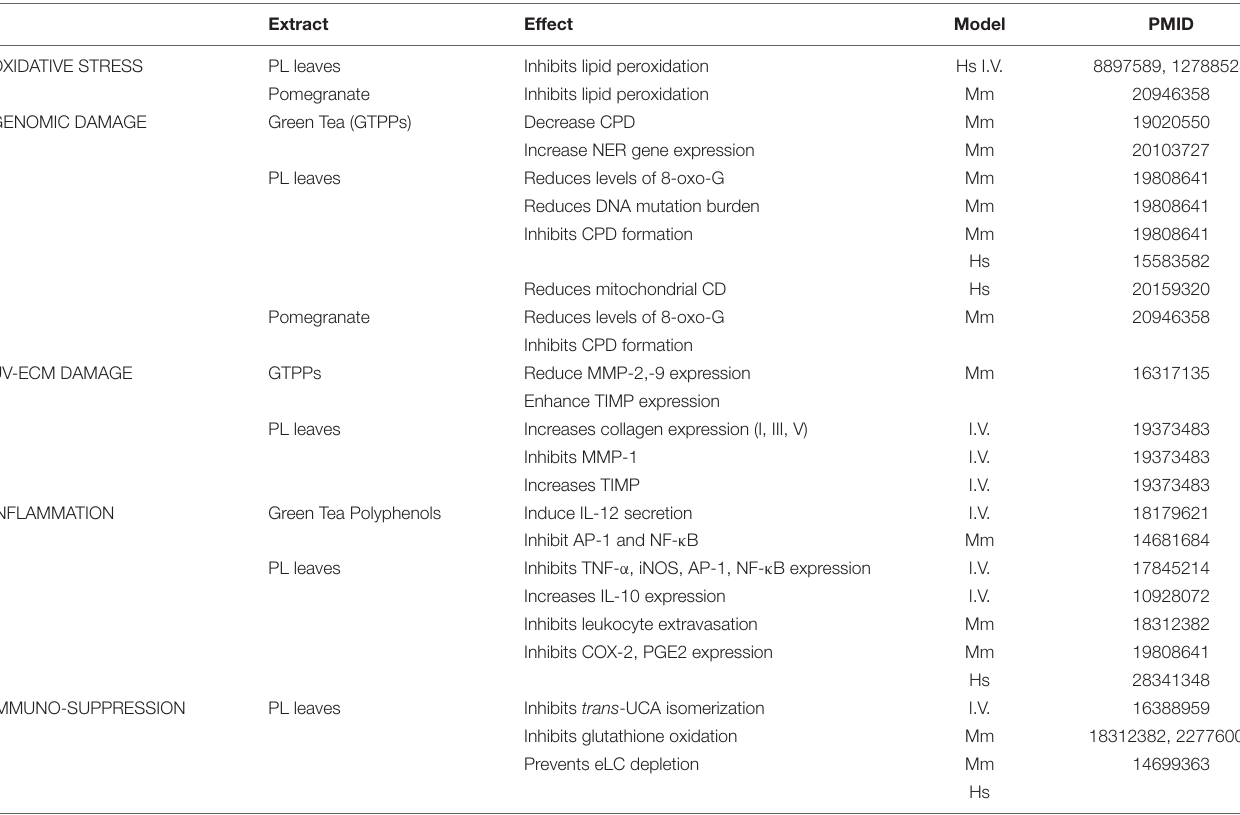
TABLE 1 | Photoprotective effects of various natural